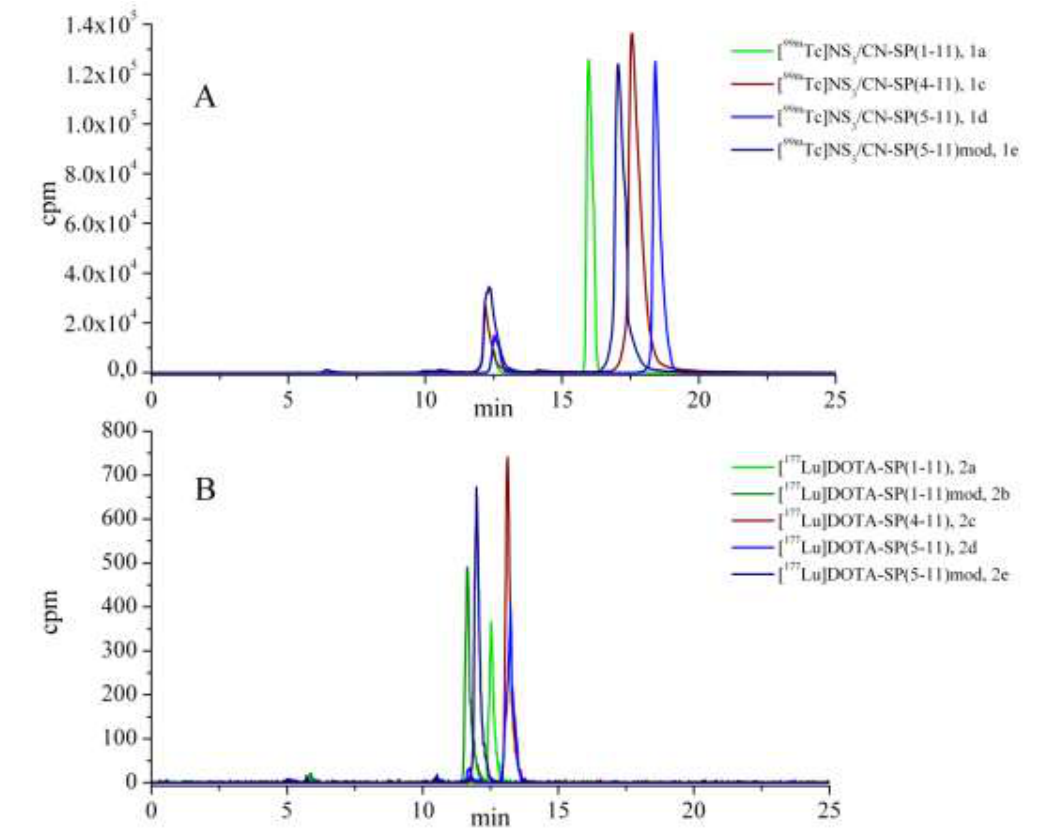
Figure 3. HPLC chromatograms (system 2) of SP analogue labeling reactions with: A: technetium- 99m ( 1a – e ):, the small peaks at R T = 12.2 – 12.5 min correspond to the intermediate complex [ 99m Tc](NS 3 ) and B: lutetium-177 ( 2a – e ).